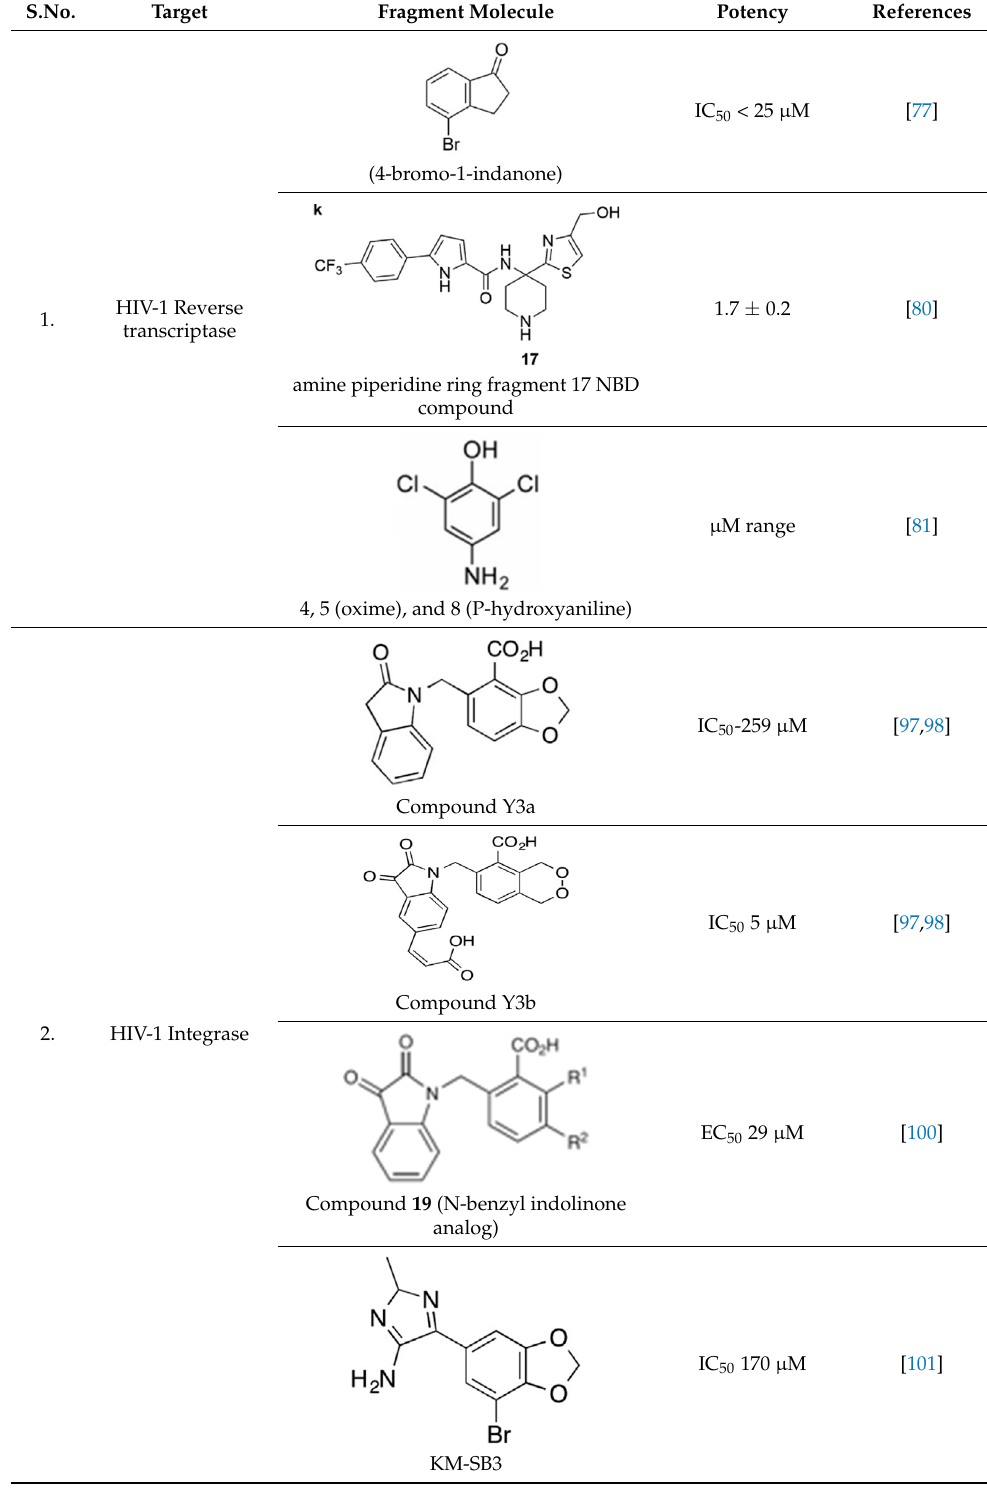
Table 5. HIV fragment molecules with their potency parameters.